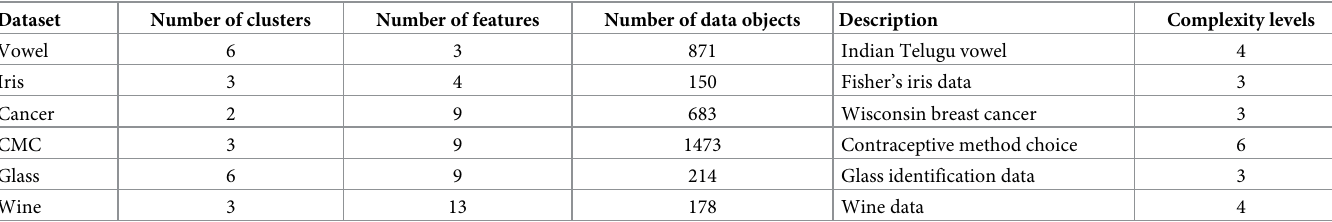
Table 1. The characteristics of the UCI repository datasets used in the experiments of AMADE algorithm. Dataset